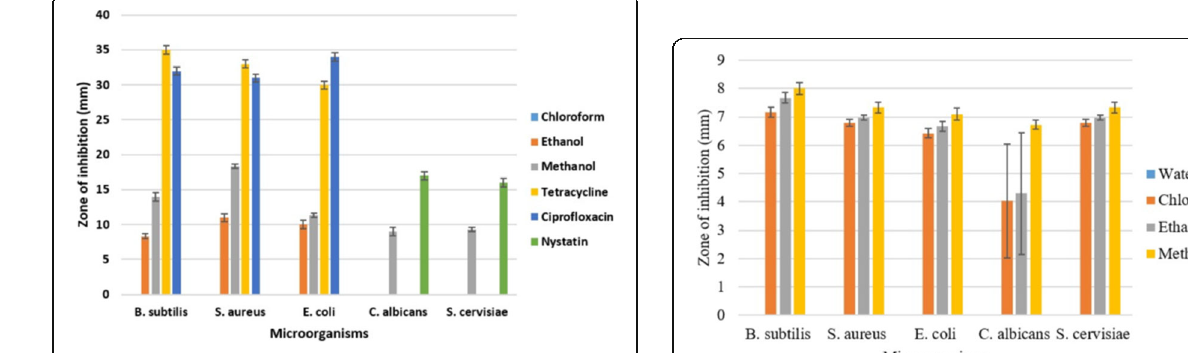
Fig. 1 Antimicrobial activity of crude extracts of O. ferruginea (leaves) compared to antibiotics